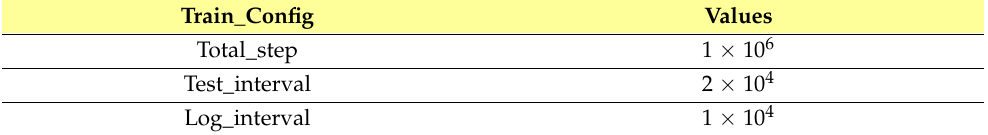
Table 2. The train configuration.